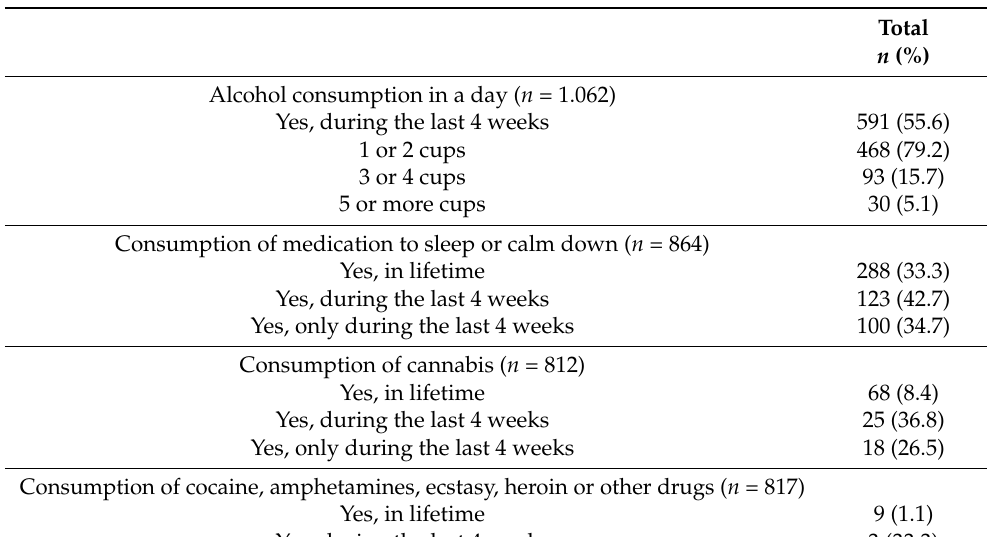
Table 1. Substance use during the first wave of